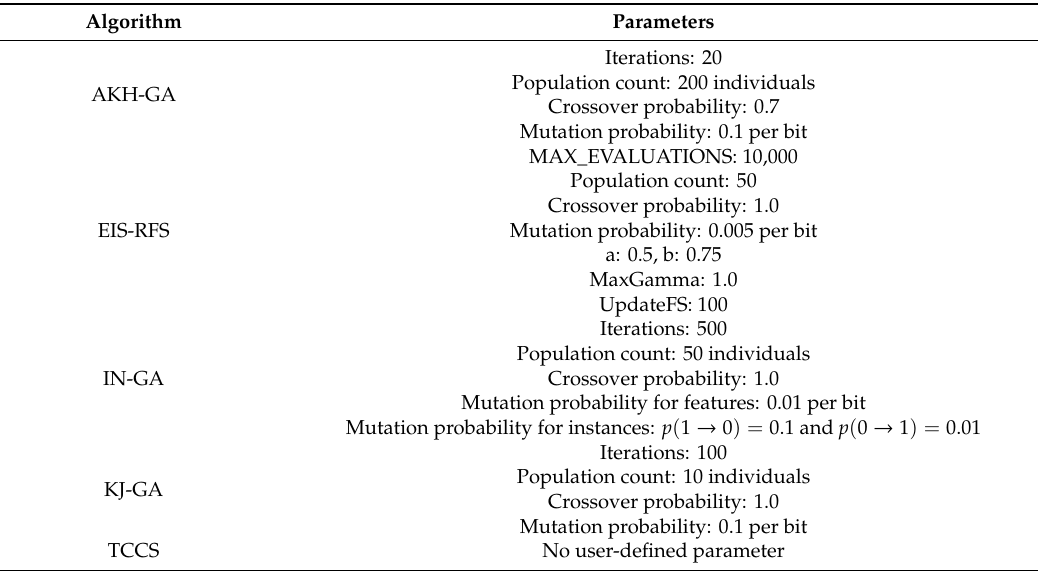
Table 8. Parameters used by algorithms under